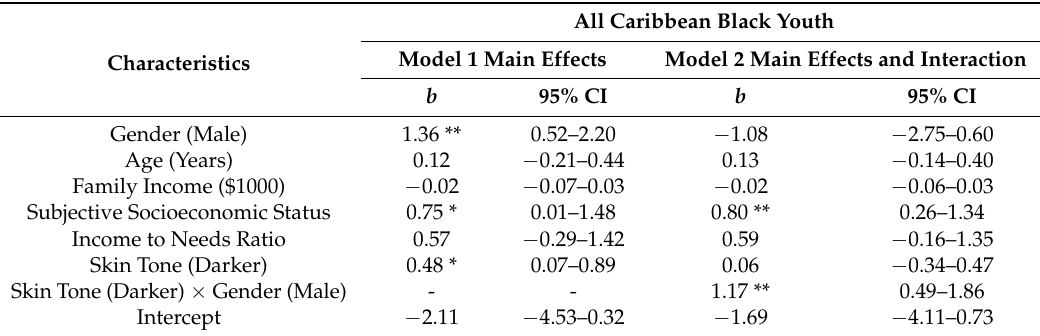
Table 3. Linear regressions in the pooled sample of Caribbean Black youth.